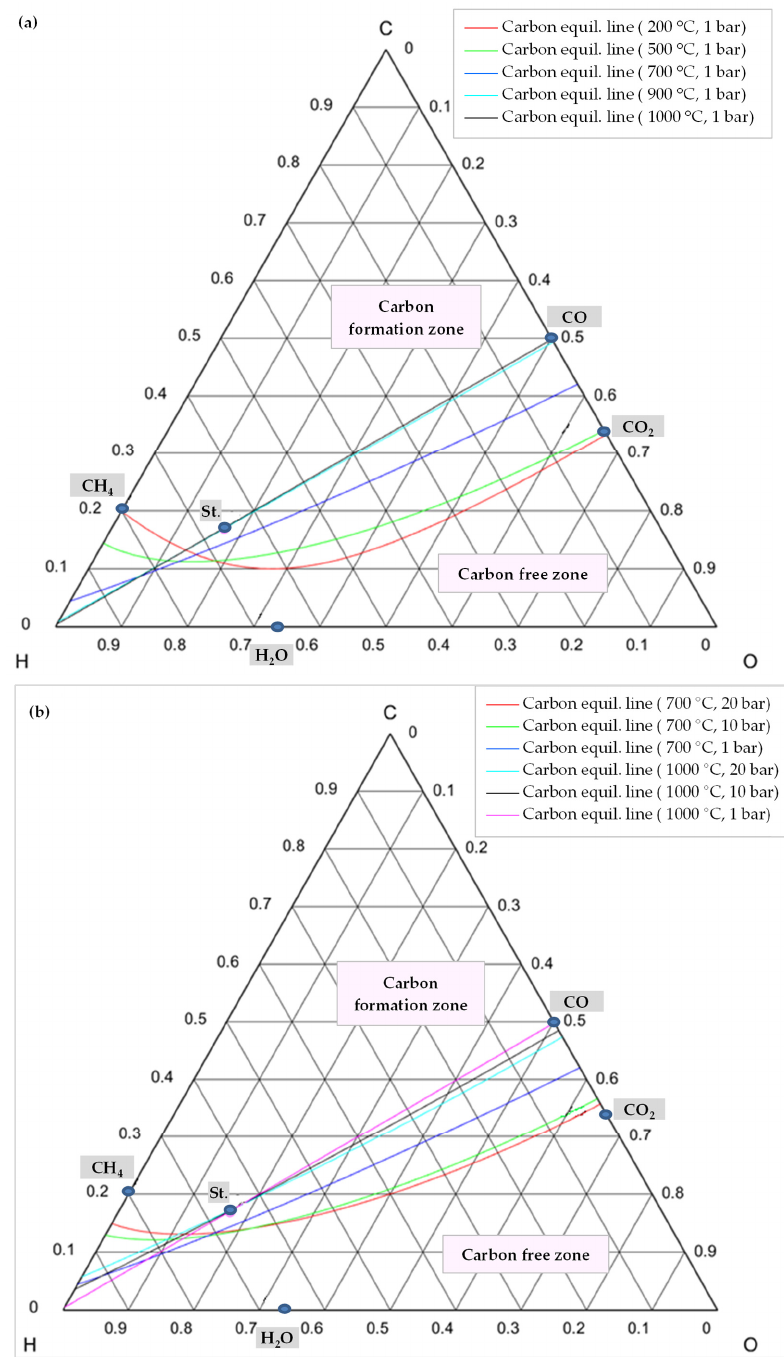
Figure 14. C-H-O phase diagram illustrating a carbon (graphite) equilibrium line ( a ) at different temperatures and 1 bar pressure, ( b ) at different temperatures and pressures, St.: CH 4 :CO 2 :H 2 O:O 2 = 1:0.5:0.25:0.125.